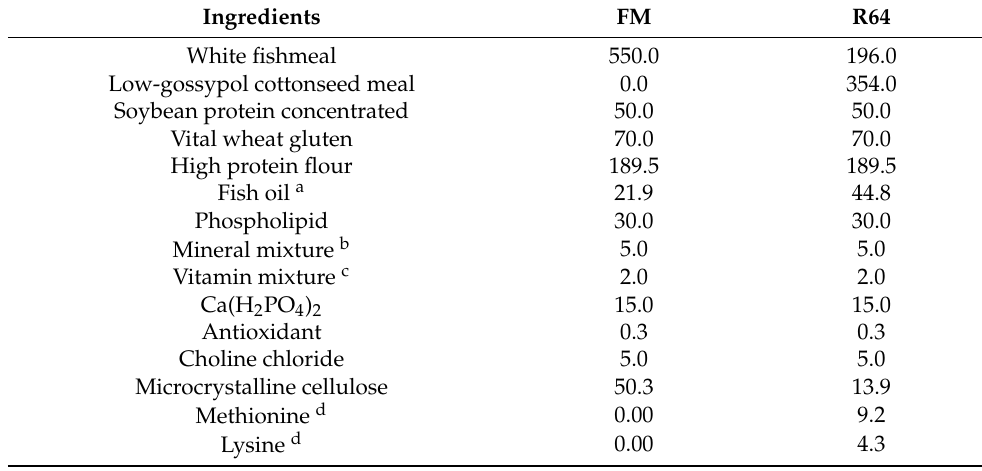
Table 2. Ingredient composition and nutrient content of experimental diets (g/kg dry